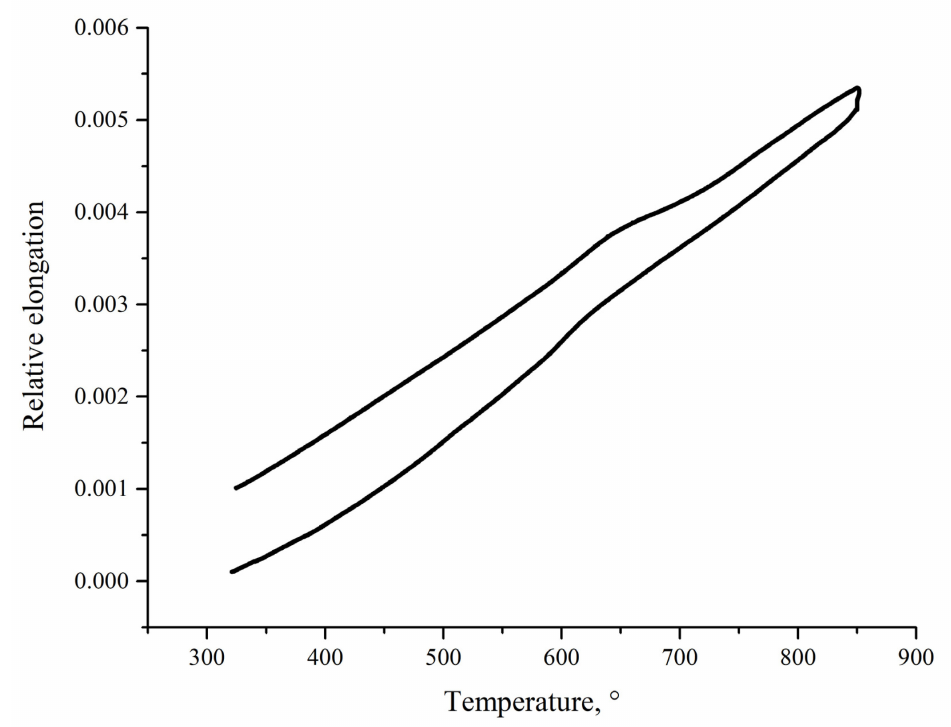
Figure 5. Dilatometric curve of the CaO-SiO 2 -B 2 O 3 sealant after heat treatment at 925 ◦ C. SEM images of the steel–sealant–steel assembly cross-sections are presented in Figure 6. Figure 6a,b features an assembly with the CaO-SiO 2 -B 2 O 3 sealant. It can be seen that